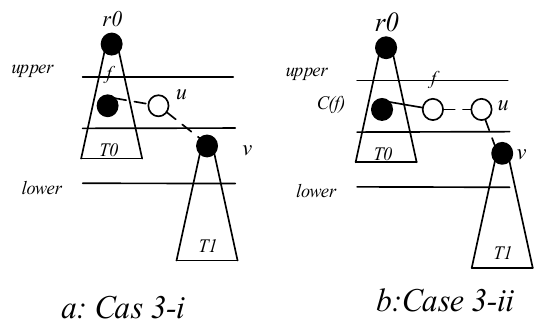
Figure 18. Connection T1 to T0 using one-hop and two-hop forwarders.